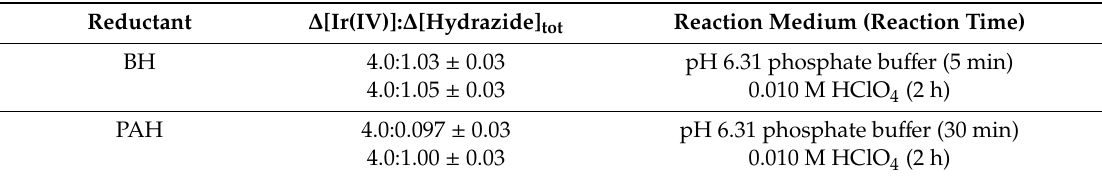
Table 1. Stoichiometric ratios determined for oxidation reactions of BH and PAH by [IrCl 6 ] 2 − at room temperature.